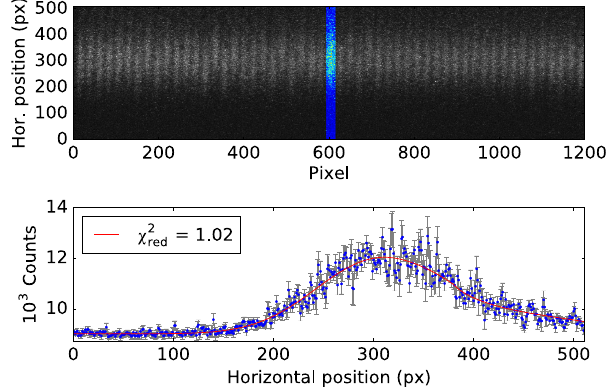
FIG. 2. FGC raw image in grey scale with the analysis range for one spot highlighted in color is shown in the top panel. The corresponding profile and the fit is plotted in the bottom